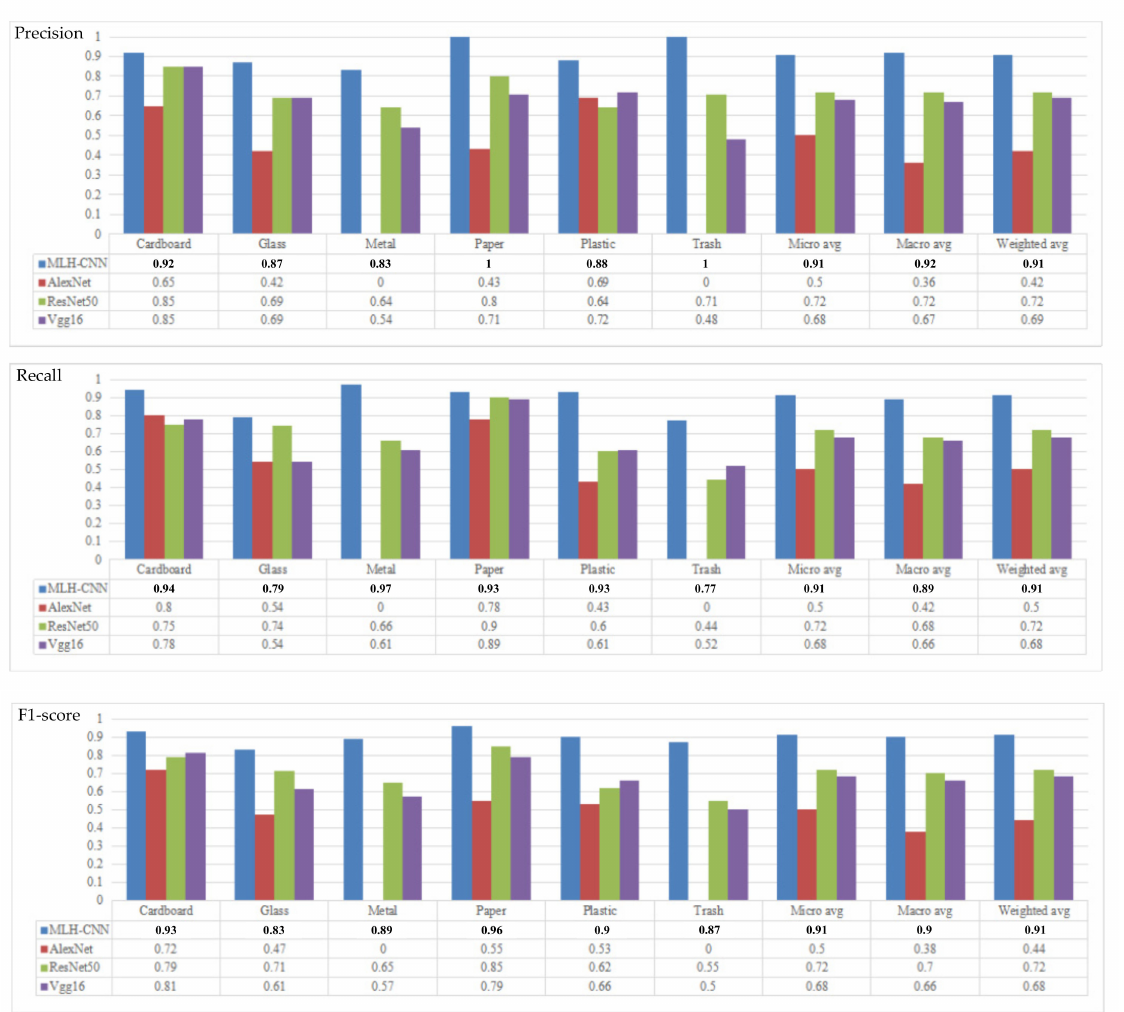
Figure 8. The results of evaluation indexes of the proposed